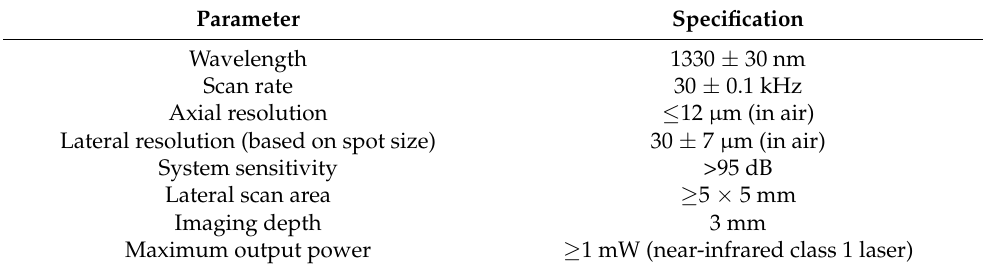
Table 2. Technical specification of CP-OCT system (cross-polarization OCT (CP-OCT; IVS-300, Santec,